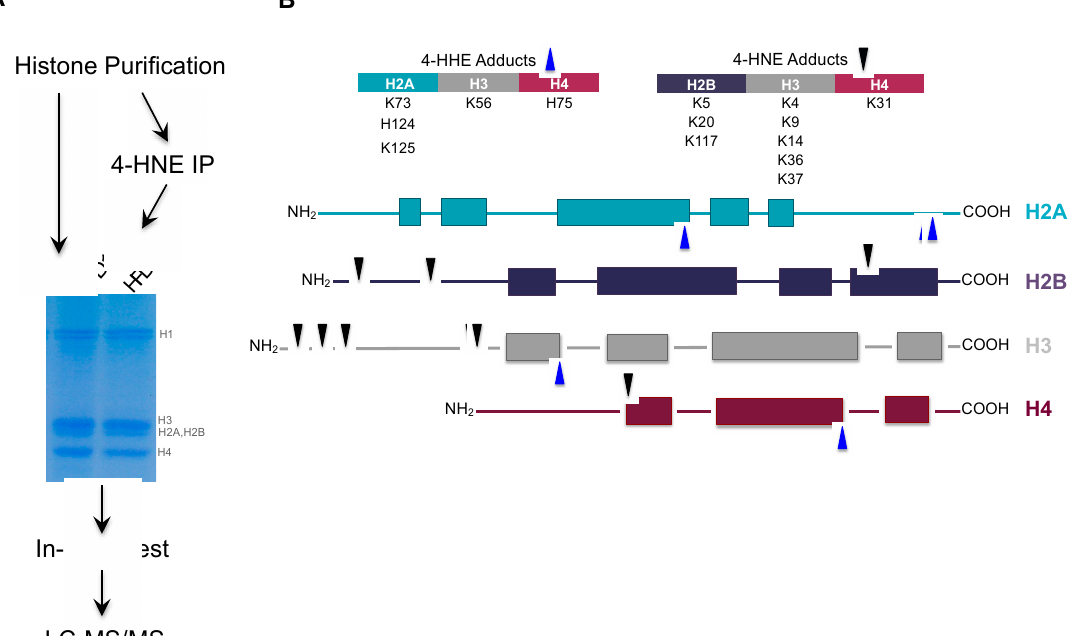
Figure 4. Identification of carbonylation sites in vivo. ( A ) Proteomic workflow for identification of sites. Both unenriched and immunoaffinity enrichment for 4-HNE-modified histones were resolved by SDS-PAGE, in gel digested, and analyzed by LC–MS/MS. ( B ) Cartoon diagram of the 4-HHE and 4-HNE adducts identified on core histones.